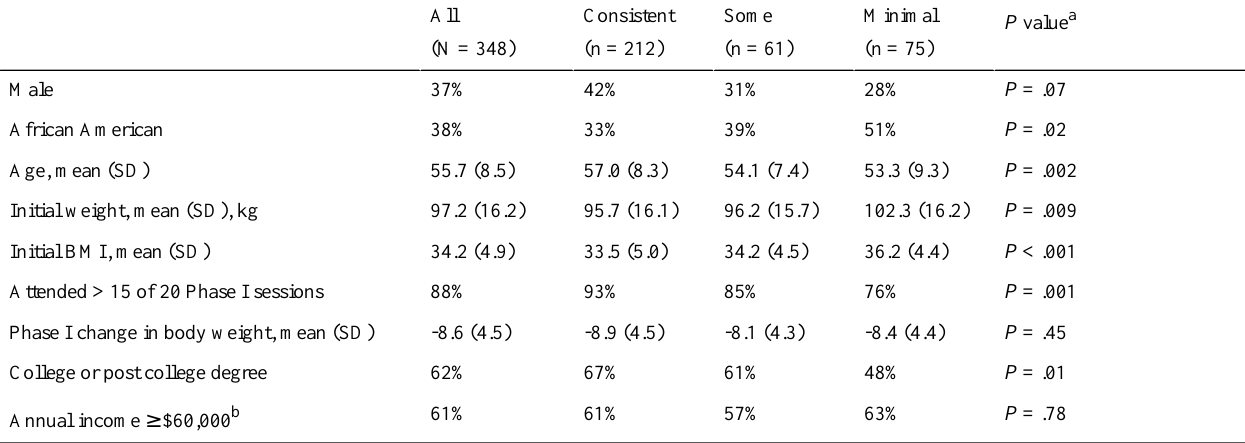
Table 1. Characteristics for all Internet participants and each subgroup category